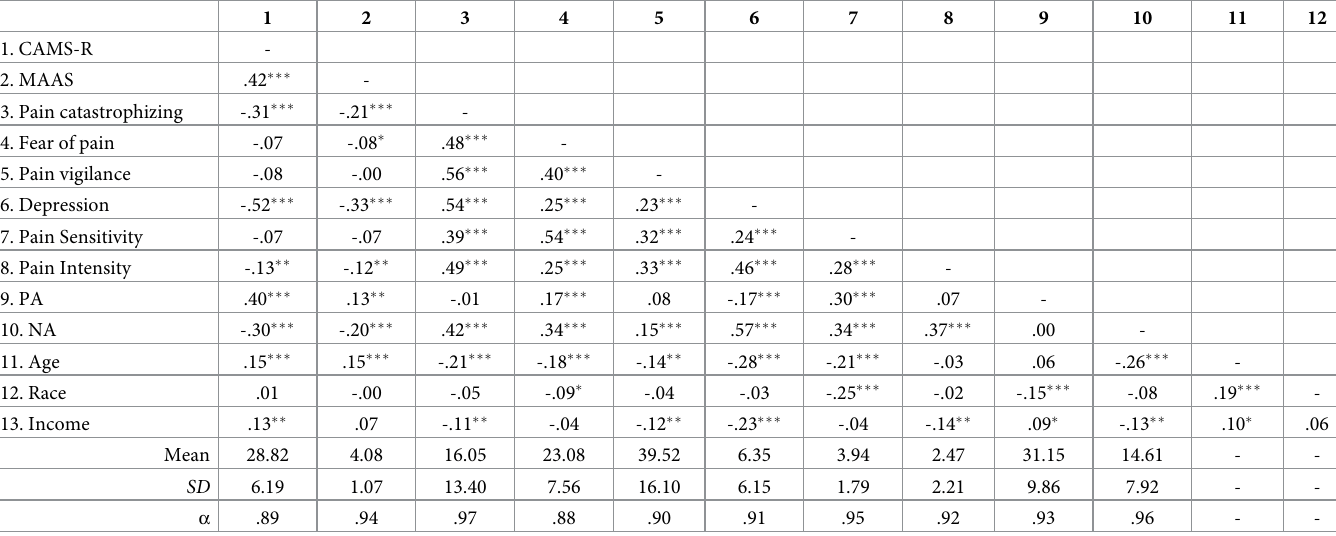
Table 2. Descriptive statistics, Cronbach’s alphas, and bivariate correlations for Study 2